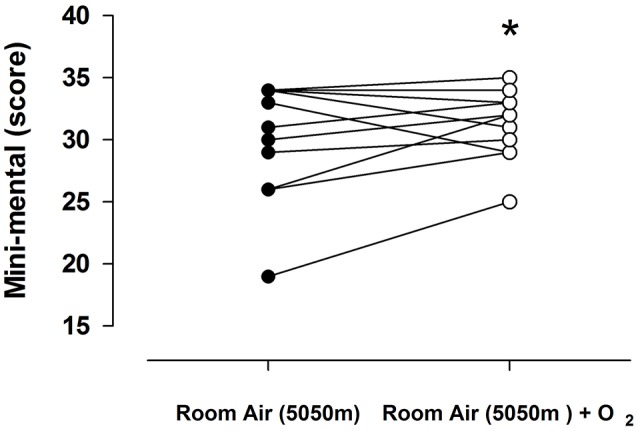
Individual response on minimental score (MMscore) in 13 subjects breathing room air of 5,050 m (open circles) and room air of 5,050 m enriched with oxygen (closed circles). Values represent the score obtained of each subject in both condition. Lines represent the mean ± SD, asterisk p < 0.001.